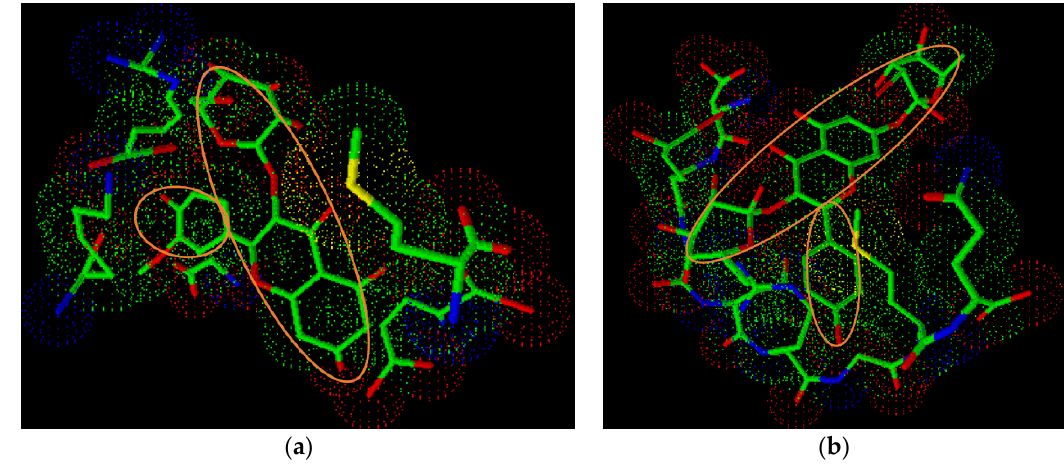
Figure 3. The protein-bound poses of the highest-scoring complexes involving ( a ) isorhamnetin-3- O -glucoside, and ( b ) kaempferol 3,7-di- O -α- L -rhamnoside (structures in the circles) at the receptor-sites of the 3QX3, and 4URO proteins, respectively.